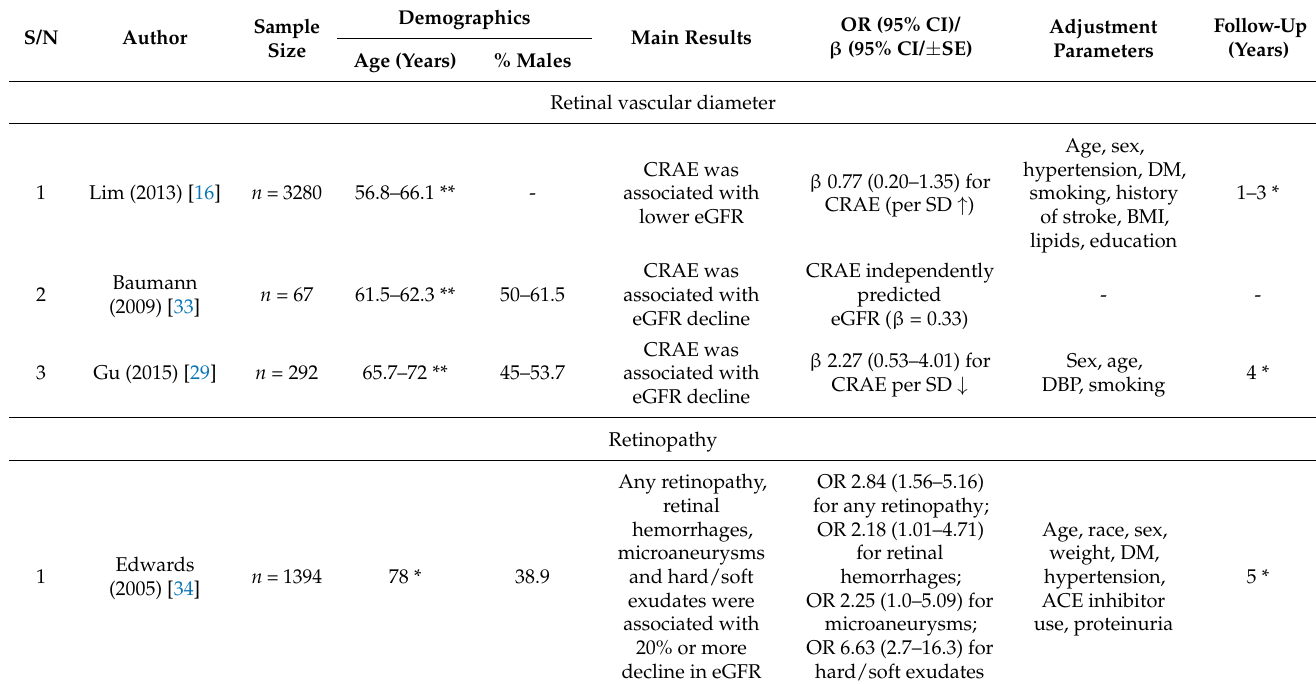
Table 5. Retinal microvascular signs and